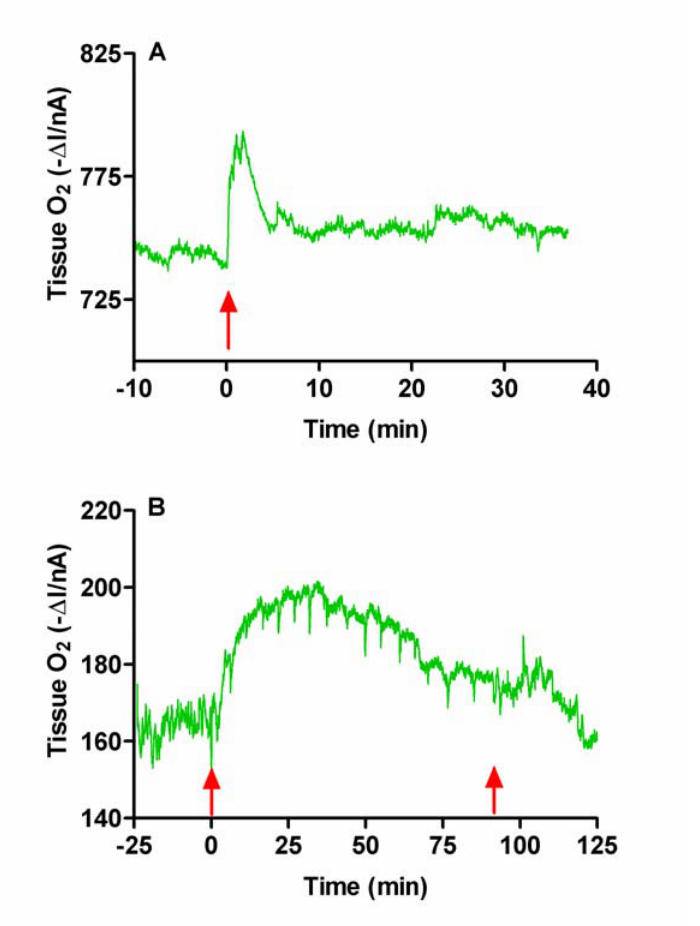
Figure 4. Typical examples of the effects of intraperitoneal injection of normal saline ( A , 0.5 mL, NaCl 0.9%) and chloral hydrate ( B , 350 mg/kg) on tissue O paste electrodes. Arrows indicate the points of injection (A & B), and recovery (B) from the